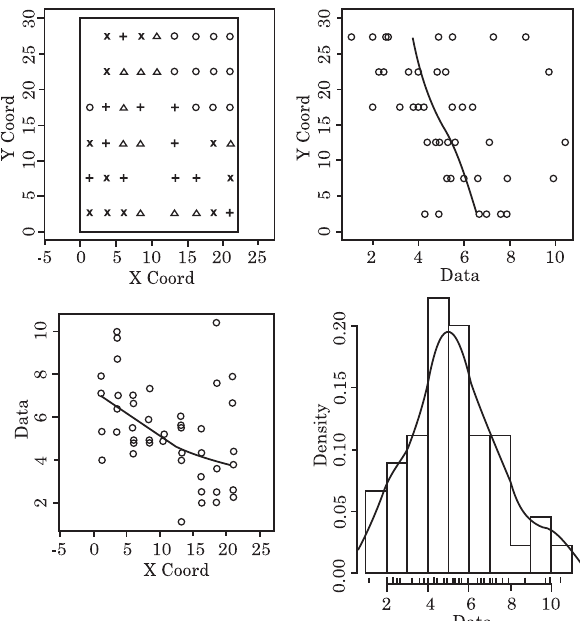
Figura 1. Pontos de locação (superior esquerdo), dispersão dos valores contra as coordenadas da área (superior direito e inferior esquerdo) e histograma (inferior direito) para o teor de fósforo no solo (mg dm - ³) em 45 pontos amostrais (excluídos os valores discrepantes) na camada 0-20 cm de profundidade do